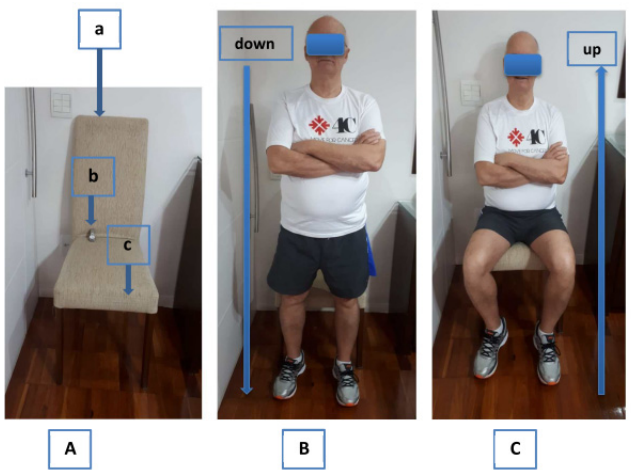
Figure 7. Steps of the five-chair stand and the minimal material required. The arrows indicate in ( A